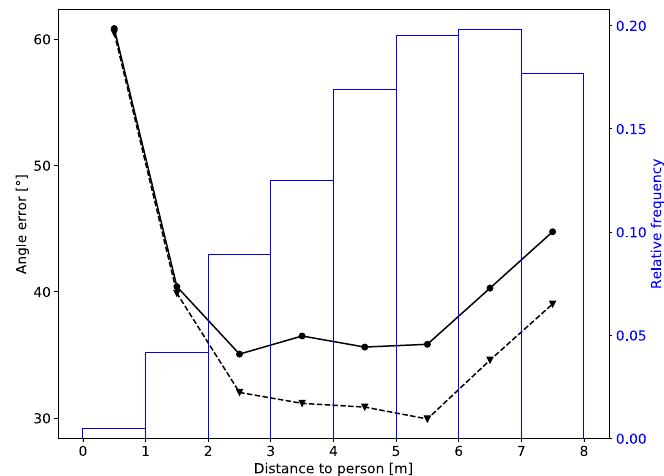
Figure 7. Dependence of the body angle error on the distance to the person: solid line—instantaneous estimate; dashed line—sequential estimate. The figure also shows the distribution of distances in the testing dataset (real world dataset).